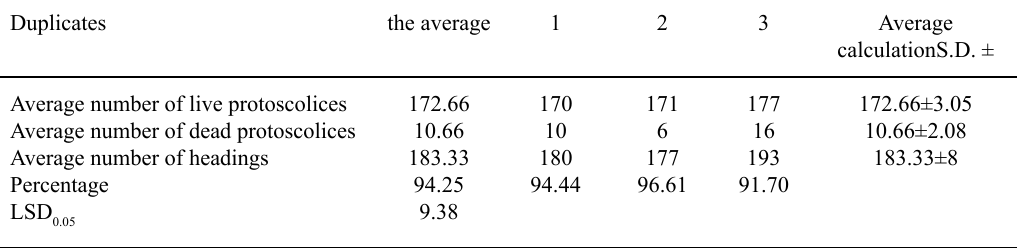
table 2. Determination of the percentage of protoscolices in 100 microliters on the first day Duplicates